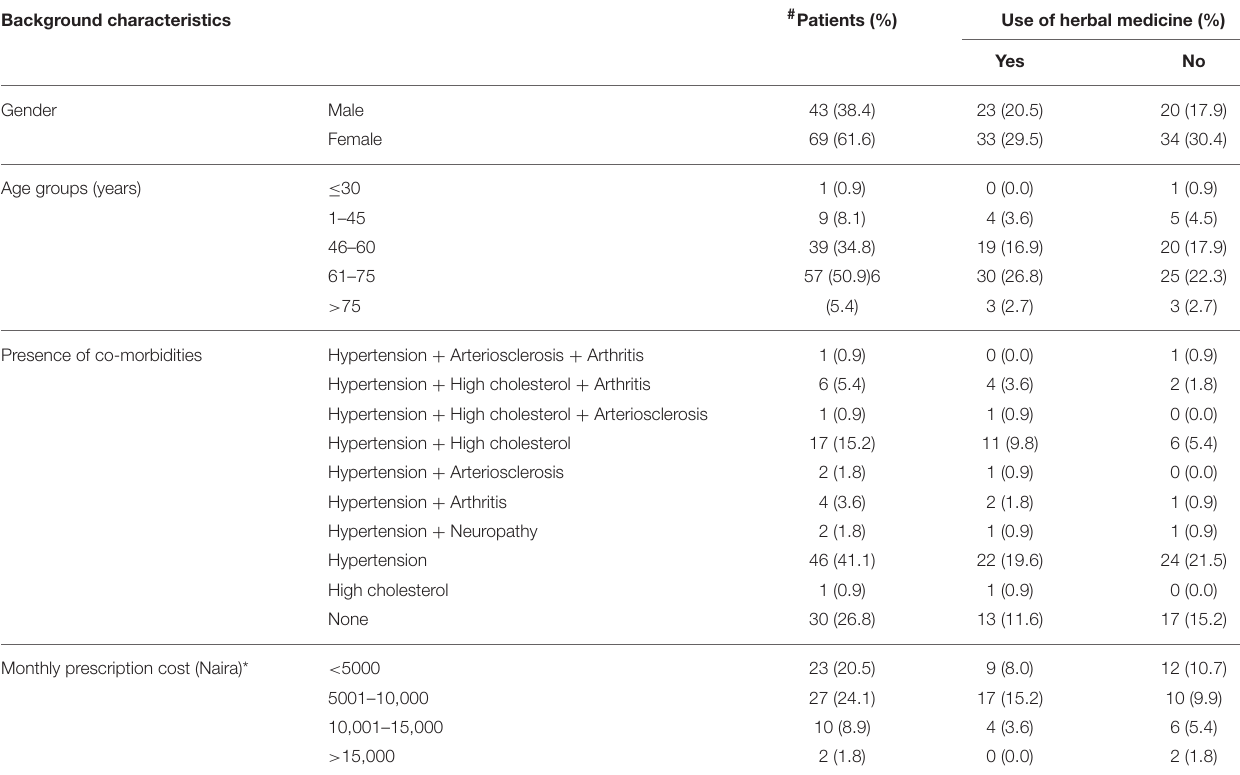
TABLE 1 | Tabular summary of data from patients with type-2 diabetes. Background